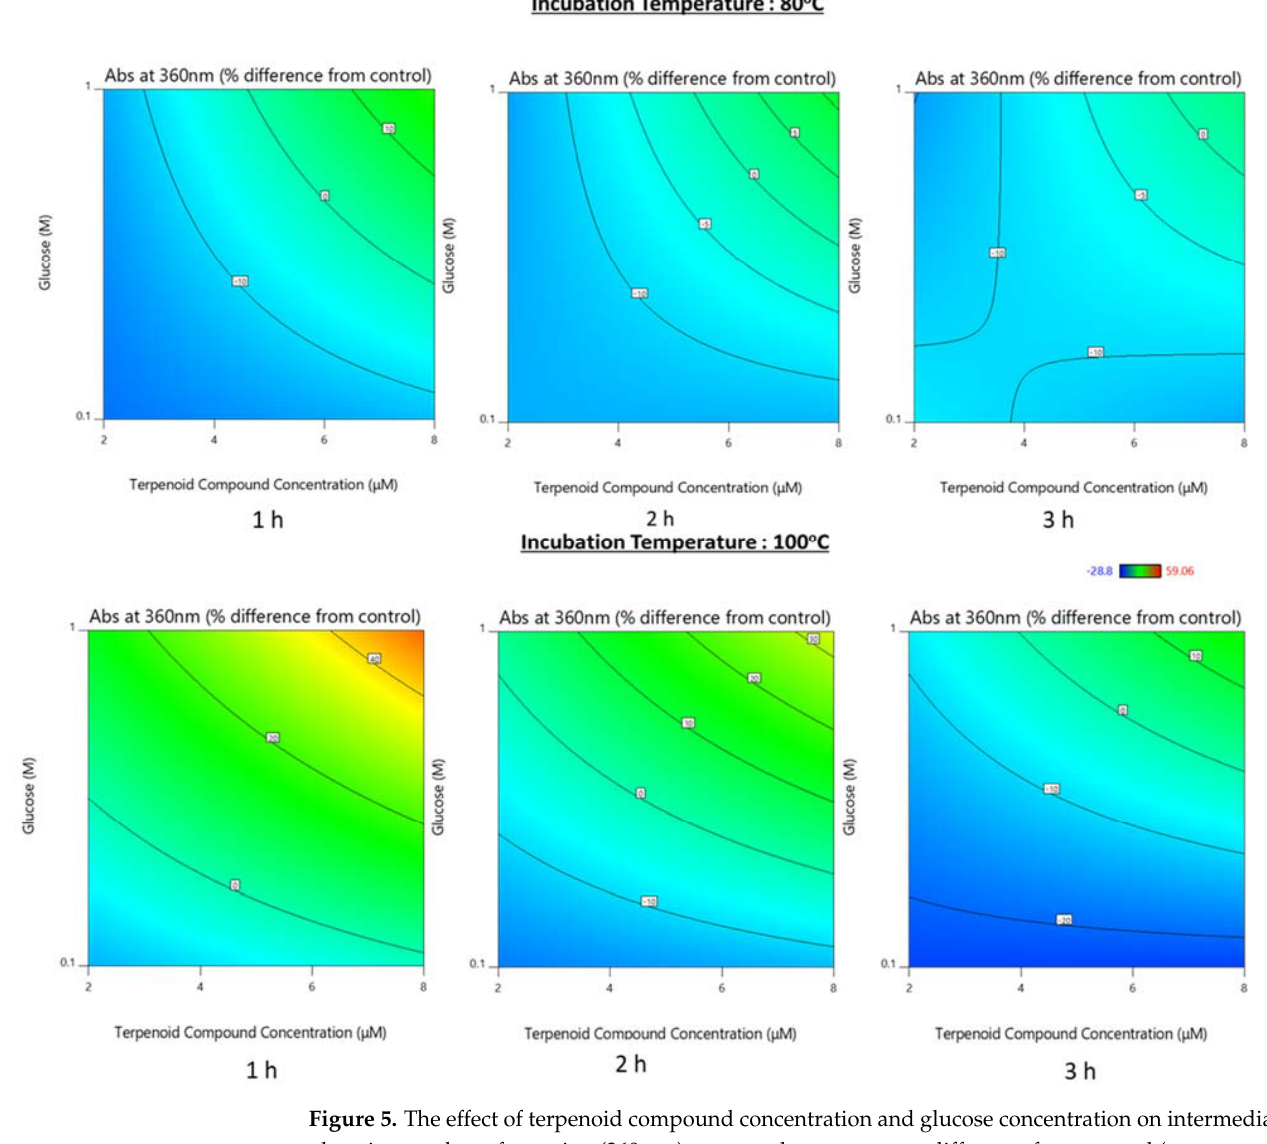
Figure 5. The effect of terpenoid compound concentration and glucose concentration on intermediate glycation products formation (360 nm) expressed as percentage difference from control (no terpenoid compound added) at pH 7.2 and 80 ◦ C and 100 ◦ C. Figures indicate average values of all three terpenoid compounds (linalool, aniseed oil and thymol).